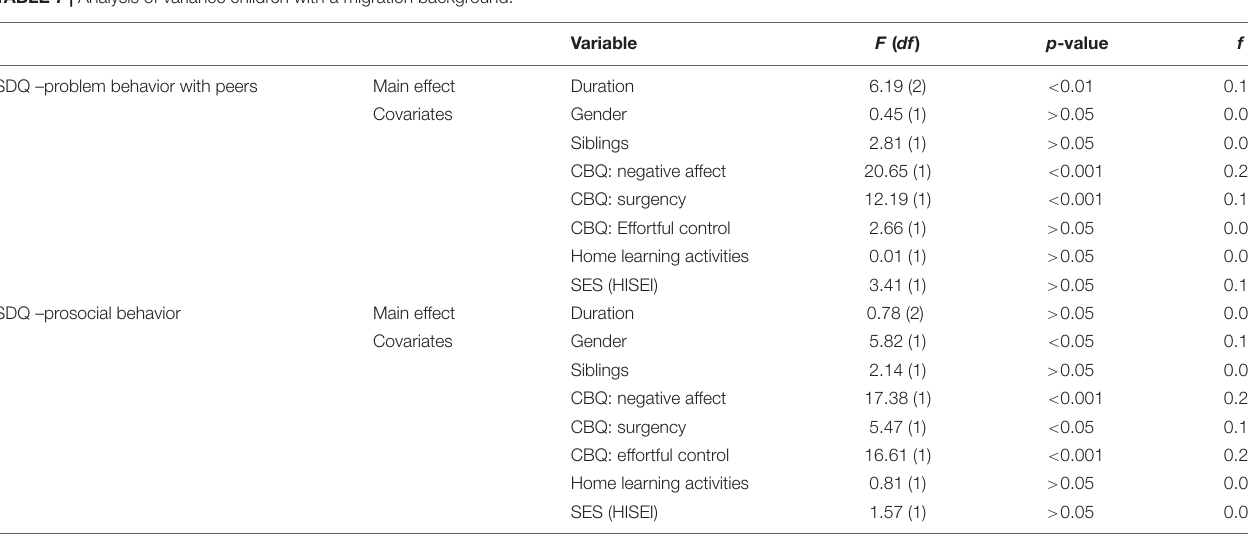
TABLE 7 | Analysis of variance children with a migration